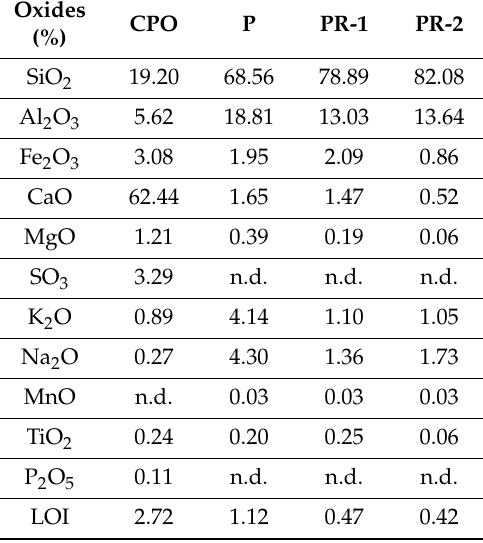
Table 1. Chemical analysis for the materials in these investigation (n.d.—not detected; LOI—loss on